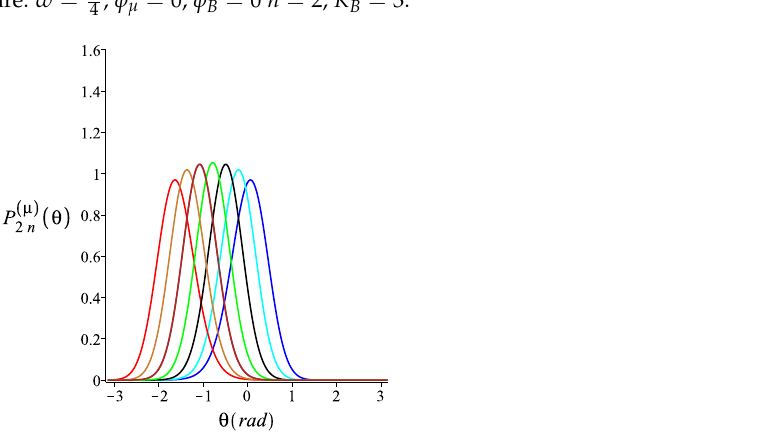
Figure 6. The probability density of orientation of the free endpoint of the grafted structure with an even number of arms. The red, gold, brown, green, black, cyan, and blue are associated with the fixed values for the orientation of the external magnetic field, φ B = − ω − π respectively. The other fixed parameters are: ω = π